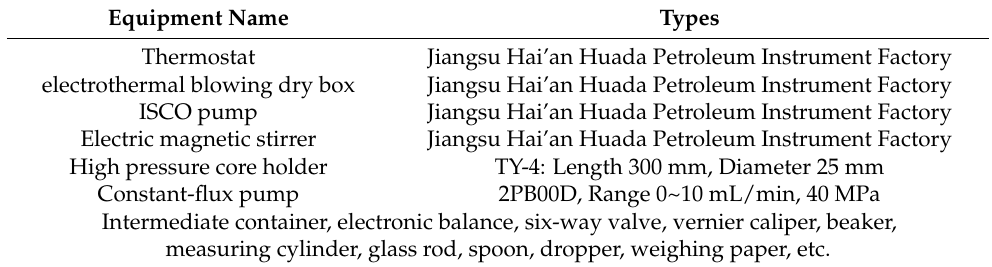
Table 18. Information on experimental equipment.